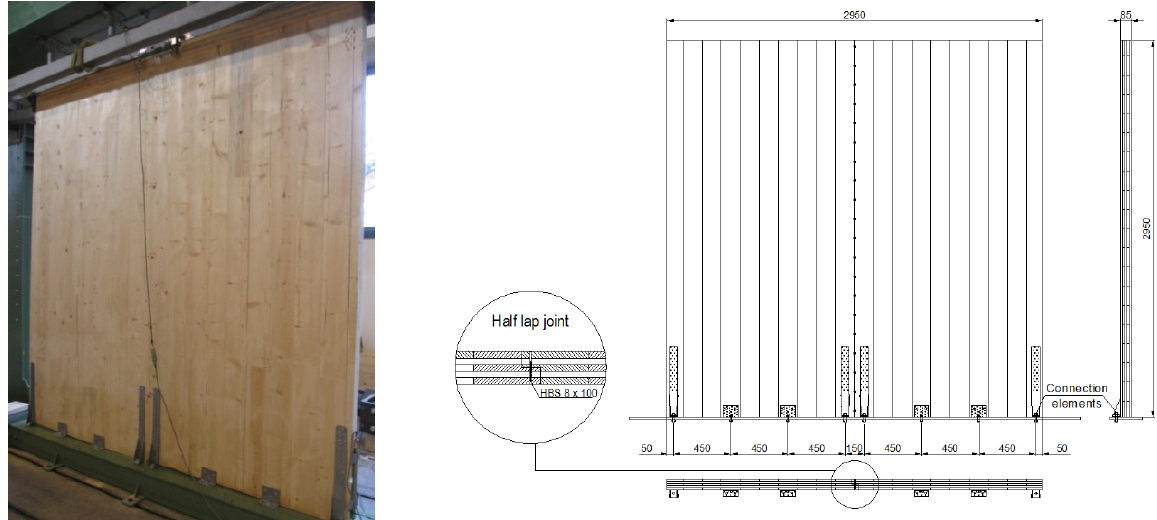
Figure 1. Wall A: Geometric arrangement, connection systems and detail of half-lap joint.